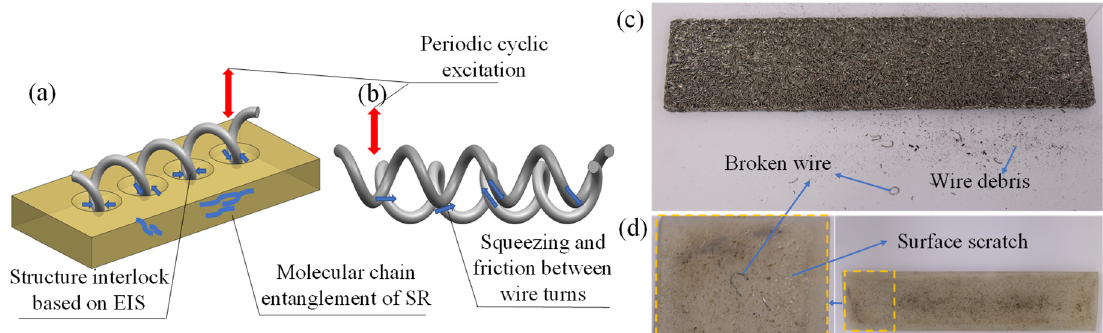
Figure 13. Schematic diagram of the physical contact interface of the different laminated structures and material wear under periodic load: ( a ) Extrusion between MR and SR; ( b ) Extrusion between Wires; ( c ) Wear of MR; ( d ) Wear of SR.